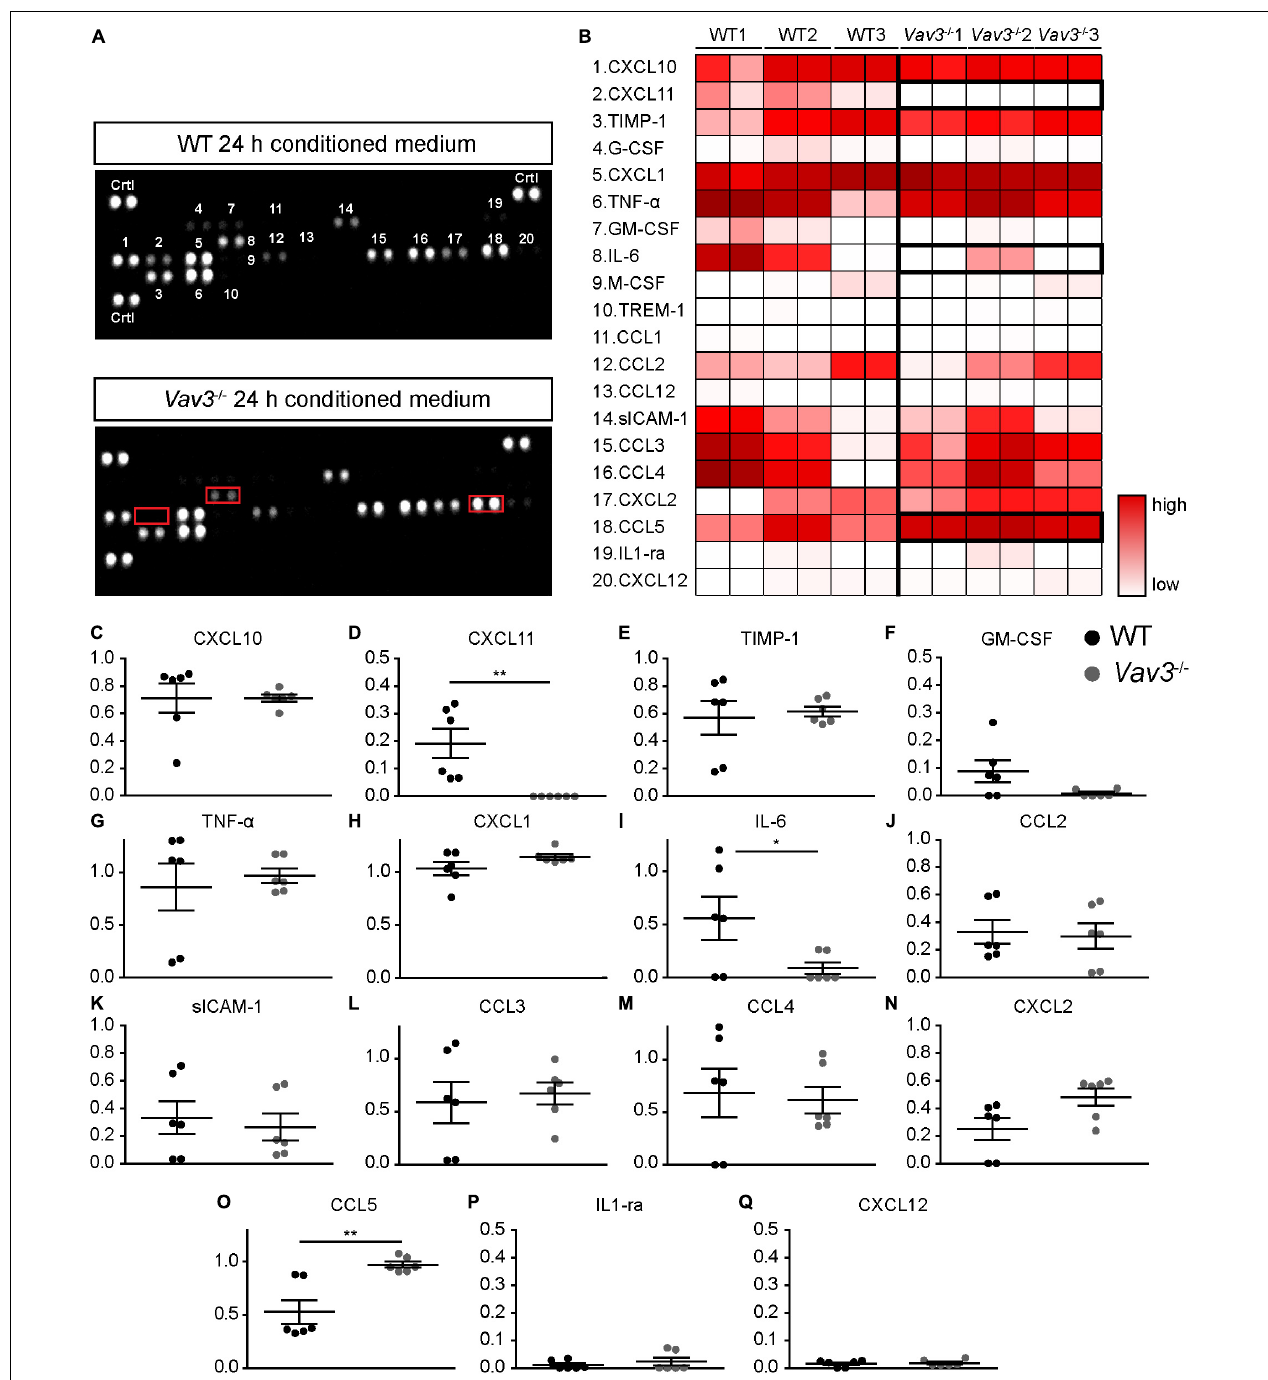
FIGURE 5 | (A) Serum-free neuronal medium was conditioned for 24 h with the secreted factors of wildtype and Vav3 − / − astrocytes. Then, cytokine arrays were used in order to determine the cytokine and chemokine profiles of both groups. The conditioned medium of Vav3 − / − astrocytes revealed an altered profile with a lack of CXCL11, reduced levels of IL-6 and increased levels of CCL5 (indicated by red boxes). (B) A total number of 20 cytokines and chemokines could be detected in the supernatants and are depicted in the heatmap. The individual numbers on the membranes are defined by the corresponding cytokine and chemokine names in the heatmap. A low cytokine level is represented by a white color while a strong level is represented by dark red colors. As indicated by the bold boxes, the conditioned medium of Vav3 − / − astrocytes showed a lack of CXCL11, increased concentrations of CCL5 and reduced levels of IL-6. (C–Q) The statistical analysis of the cytokine array confirmed these observations. Since the concentrations of Trem1, CCL1, G-CSF, M-CSF, and CCL12 were exceedingly low in the supernatants they were shown in detail by diagrams. The exact values can be found in the result part 3.3. Statistics: Three experimental repetitions ( N = 3) were performed, and two technical replicates ( n = 2) were considered per repetition. Unpaired t -test, * p ≤ 0.05, ** p ≤ 0.01 and *** p ≤ 0.001, data are represented as mean ± SEM.